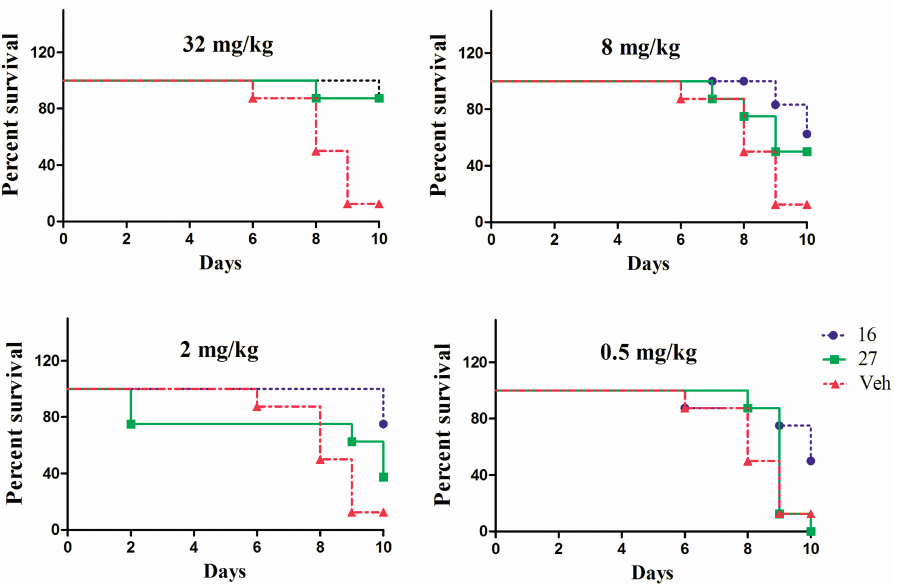
Figure 4. Survival rate of mice after injection of C. albicans 64110. FLZ stands for fluconazole and indicates a statistically significant difference compared to the control group. The four tested dosages of 31 and 42 were 32, 8, 2 and 0.5 mg/kg.